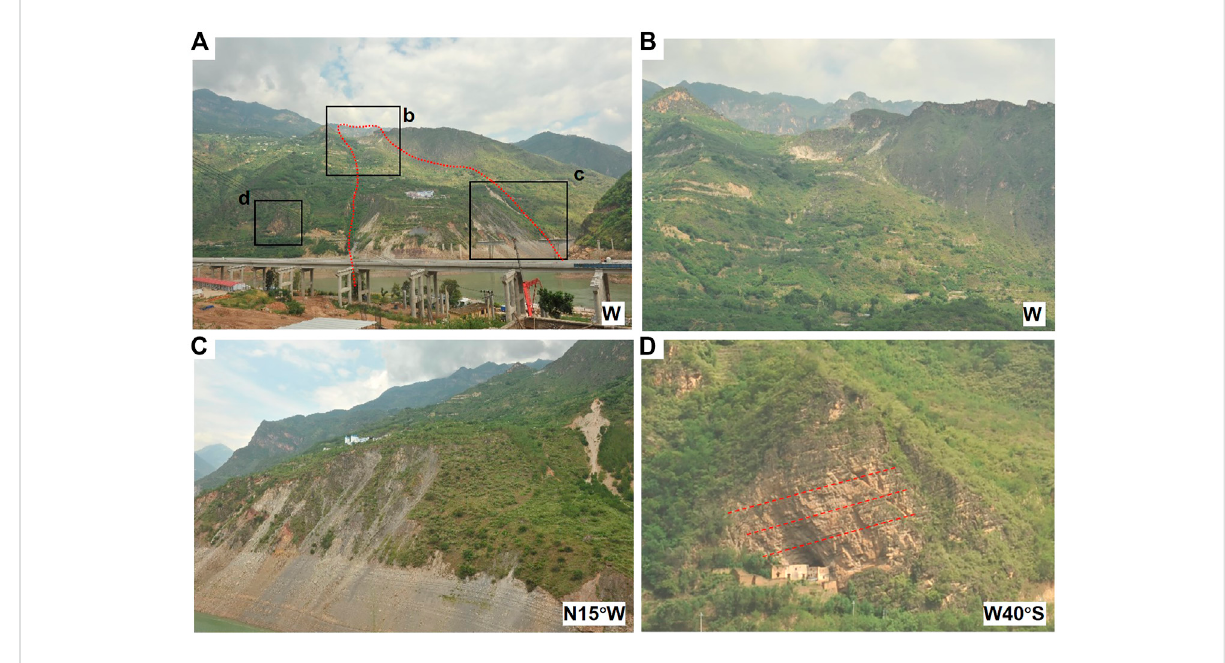
FIGURE 2 SitephotosoftheNLJLtakeninApril2022. (A) Photoofthelandslideandthelocationsof fi guresb,c,d; (B) Crownofthelandslide; (C) Rightfoot of the landslide; (D) Anti-dip rock slope.: The camera ’ s direction was marked in the lower right corner.